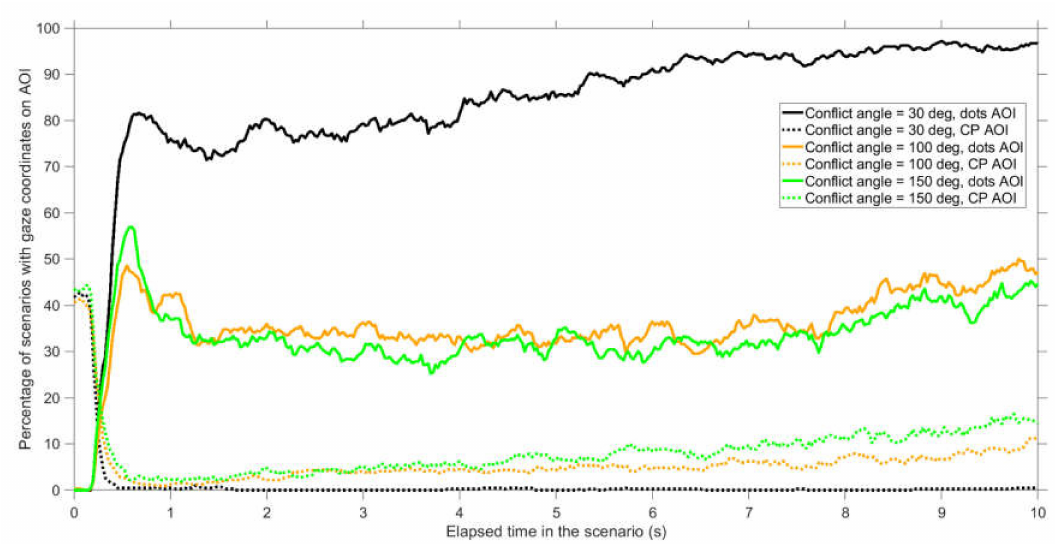
Figure 8. Percentage of participants with gaze coordinates in an area of interest (AOI) as a function of elapsed time in the scenario. A distinction is made between AOIs surrounding the dots (dots AOI) and the AOI surrounding the conflict point (CP AOI). The shown values represent averages for 35 participants and 12 scenarios per participant (conflict scenarios and non-conflict scenarios combined). For example, at an elapsed time of 4 s, for scenarios with 30 deg conflict angle, participants looked at the dots AOI in 342 of the 420 cases (81.4%), and at the CP AOI in only 1 of the 420 cases (0.2%). Only the first 10 s of the scenario are shown because from 10 s onwards, the AOIs started to overlap.